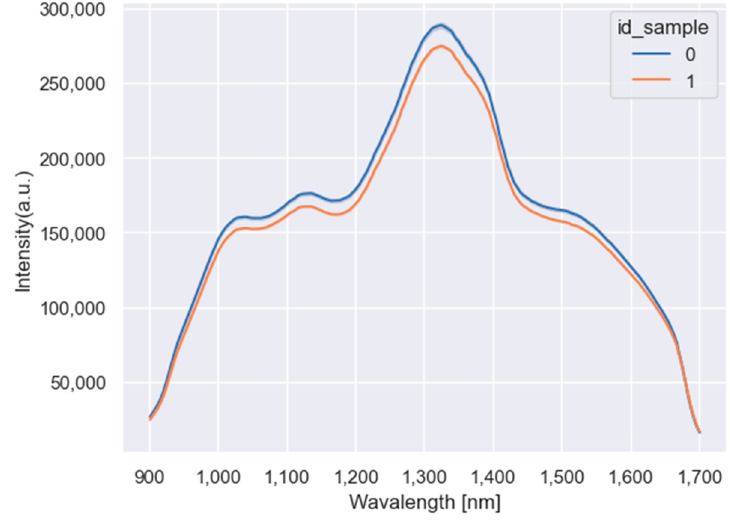
Figure 3. Mean of the flour samples doped with 0 g/kg (blue line) and 100 g/kg of gluten (orange line).